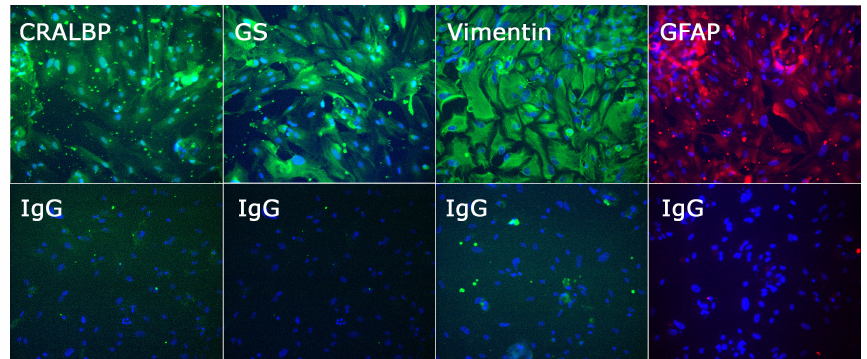
Figure 5. Photomicrographs of Müller cells isolated from human retinae and phenotyped by immunocytochemistry for cellular retinaldehyde binding protein (CRALBP), glutamine synthetase (GS), vimentin, and glial fibrillary acidic protein (GFAP), with negative control labelled with species-matched primary antibody (IgG). Cells stained positively for CRALBP, GS, vimentin, and GFAP; staining artefacts were visible in the negative control, but the labelling pattern was clearly di ff erent. Alexa Fluor 488 (green) or Alexa Fluor 594 (red) with DAPI nuclear counterstain (blue). Original magnification: 200 ×